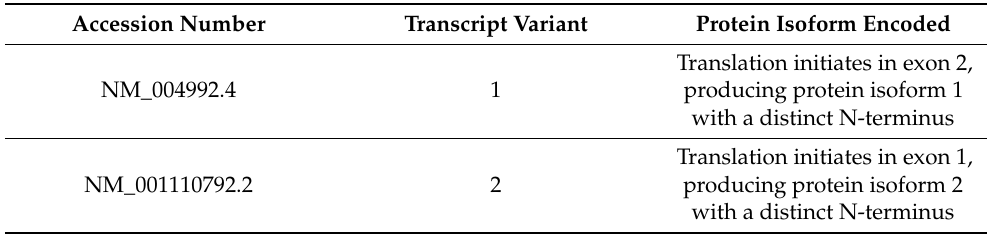
Table 1. Summary of NCBI MECP2 mRNA variants and their respective protein isoforms. (Updated 15 October